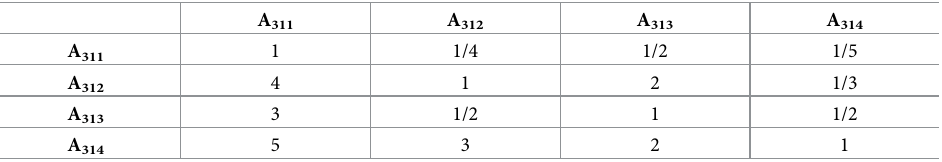
Table 12. Pairwise comparison matrix of the information orientation